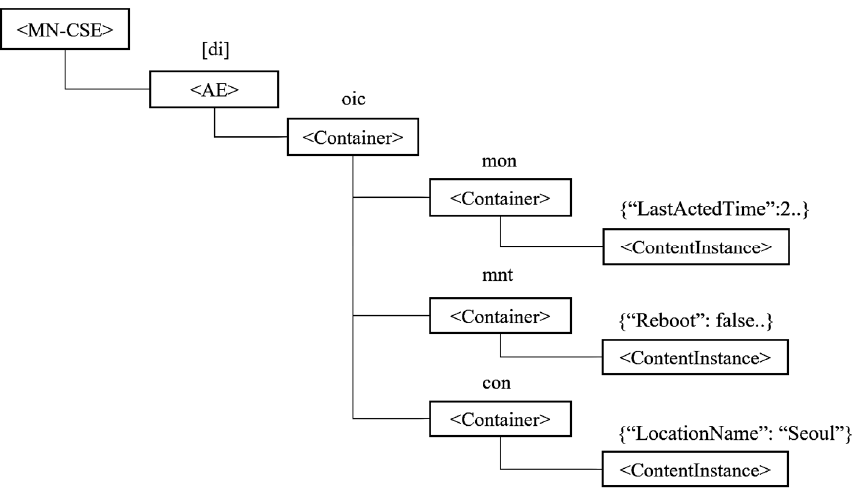
Figure 6. IoTivity resource mapping to oneM2M resource structure.